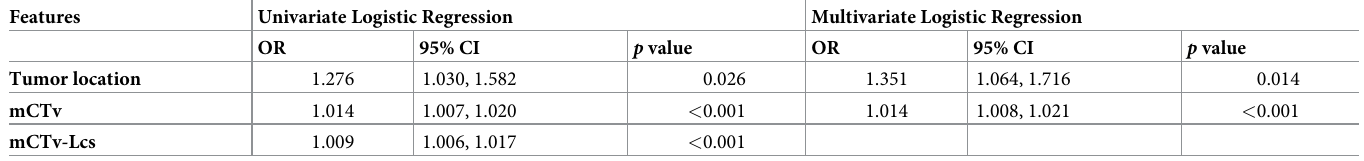
Table 2. Univariate and multivariate logistic regression analysis for the baseline